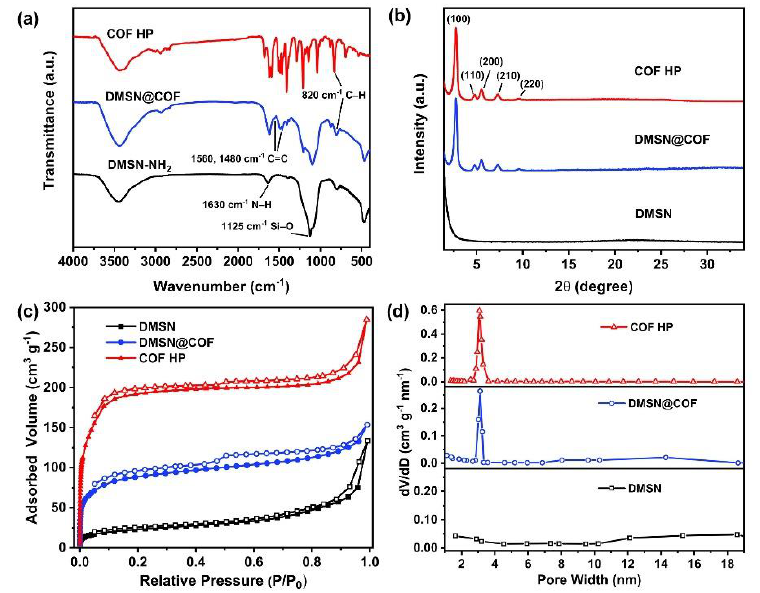
Figure 3. The FTIR spectra ( a ), XRD patterns ( b ), nitrogen adsorption–desorption isotherms ( c ), and pore size distribution ( d ) of DMSN, DMSN@COF, and COF HP. The XRD patterns of DMSN, DMSN@COF, and COF HP are shown in Figure The surface area and porosity of the samples were determined from the N 2 adsorp- tion – desorption isotherms (Figure 3c). DMSN@COF and COF HP were discovered to have